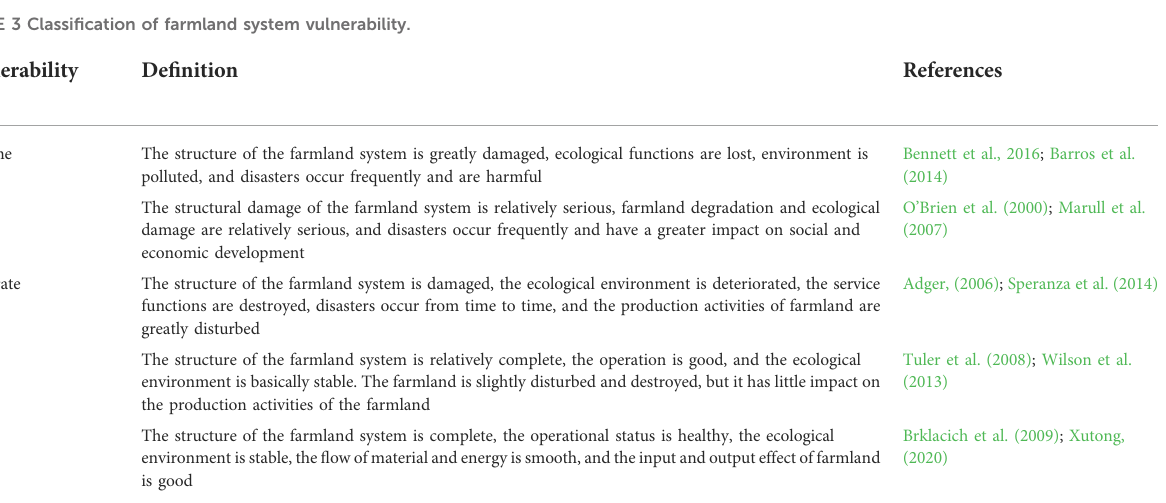
TABLE 3 Classi fi cation of farmland system